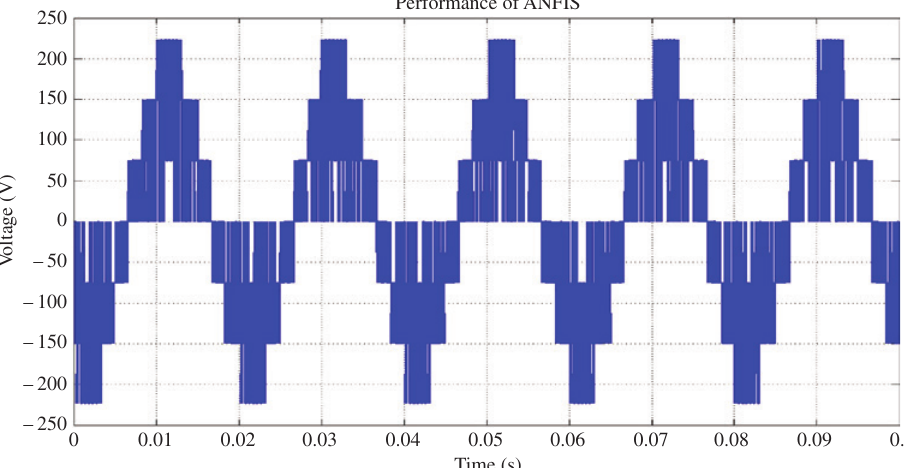
Figure 10: Seven-Level Inverter Output Voltage with ANFIS.